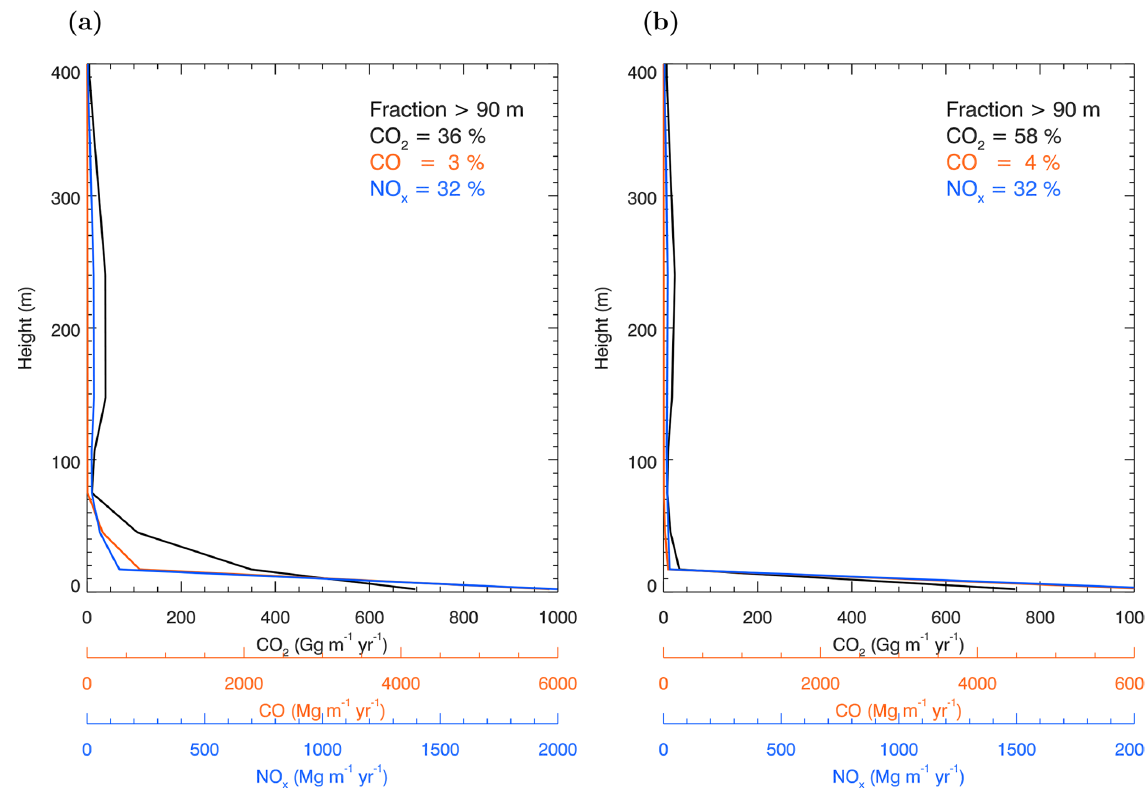
Figure 5. Monthly mean vertical emission profiles of CO 2 , CO and NO x over Berlin in (a) February and (b)